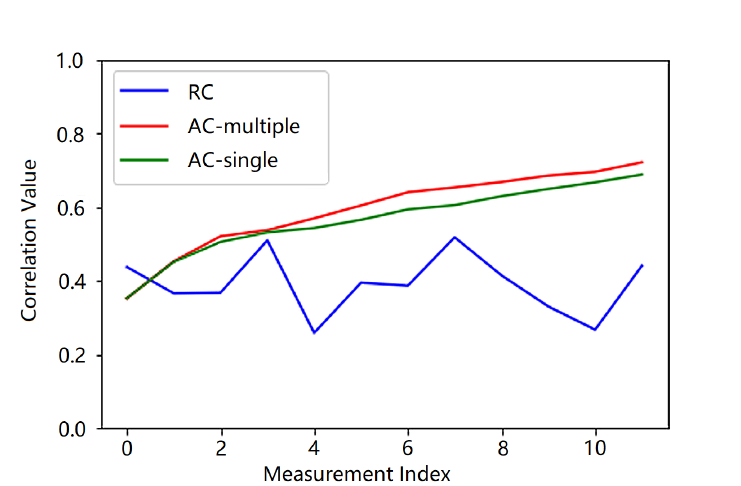
Figure 7. Correlations between the Compressive Measurement Kernels and the Used PN Sequence (RC: Conventional compressive detection with random measurement kernels; AC-multiple: Adaptive compressive detection with the multiple neural network strategy; AC-single: Adaptive compressive detection with the single neural network